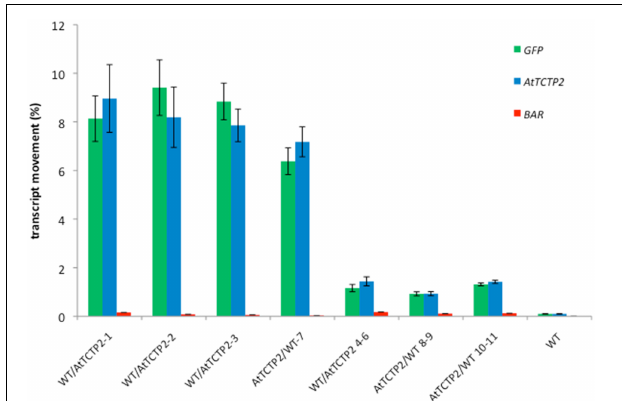
FIGURE 2 | Quantification of AtTCTP2-GFP mRNA long distance movement suggests preference for directional movement from rootstock to scion. Total RNA was extracted from transgenic or WT rootstocks and scions and homogenized to a given concentration (100ng/ µ l) to be used as templates to perform Real Time qRT-PCR. GFP (green) and AtTCTP2 (blue) were quantified in all cases, using BAR as a negative control for mRNA movement. mRNA movement percentages for GFP, AtTCTP2 and BAR from rootstock to scion (WT/AtTCTP2-) and vice versa (AtTCTP2/WT) were determined by relating fold changes between transgenic and wt components on the graft after normalizing against 18S as reference gene. Three technical replicates were performed in each case, given as means ±